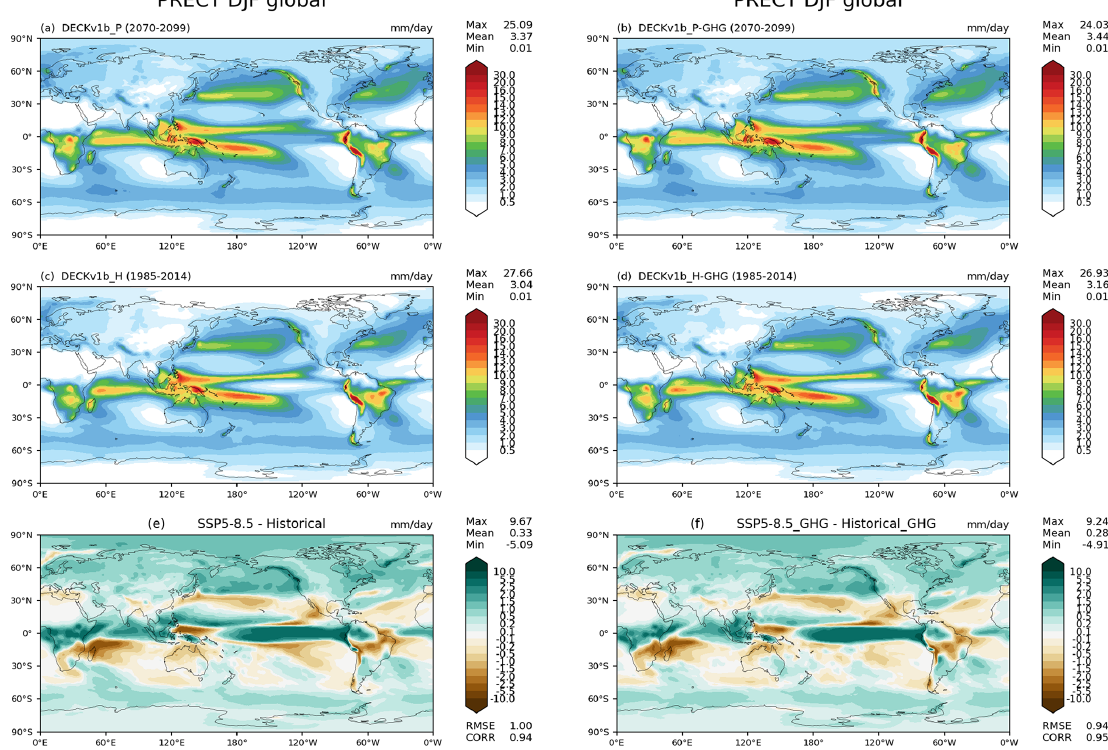
Figure A1. DJF mean precipitation rate (mmd − 1 ) from (a) five SSP5.85 ensemble simulations (2070–2099), (c) five historical ensemble simulations (1985–2014), and (e) the change between the time period of 2070–2099 and the period of 1985–2014. DJF mean precipitation rate (mmd − 1 ) from (b) three SSP5.85-GHG ensemble simulations (2070–2099), (d) three historical-GHG ensemble simulations (1985–2014), and (f) the change between the time period of 2070–2099 and the period of